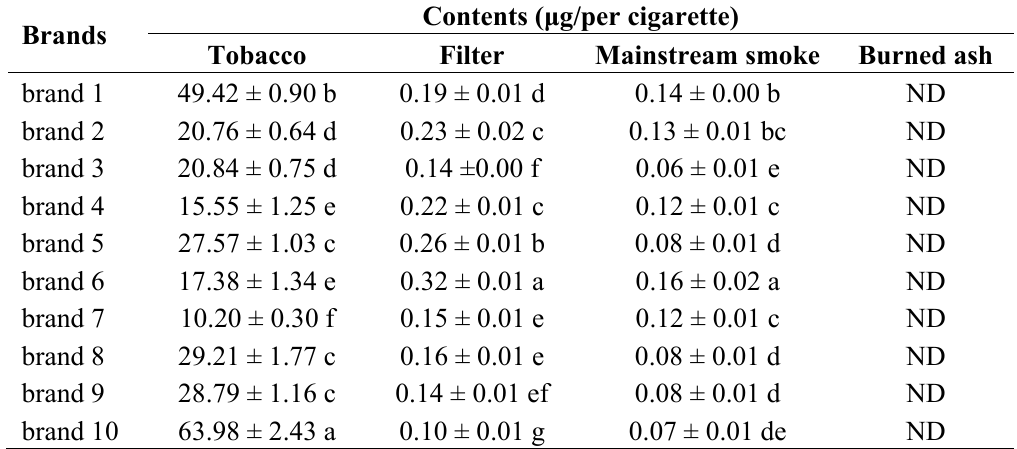
Table 3. Amount of rutin in tobacco , filter, smoke and burned ash of ten brands cigarettes ( n =